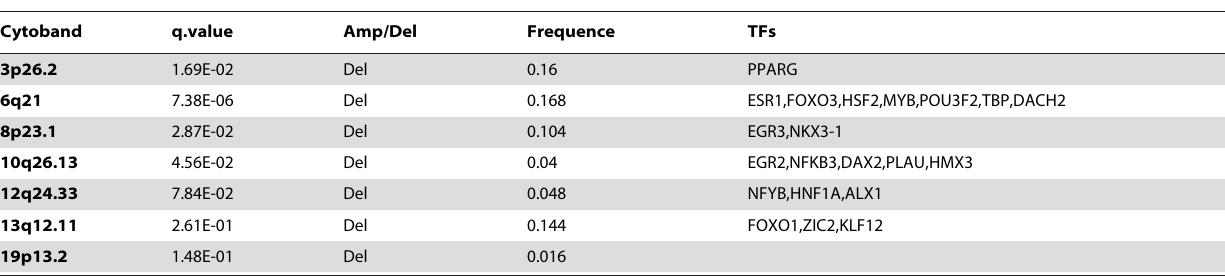
Table 1. CNV-regions containing TFs.